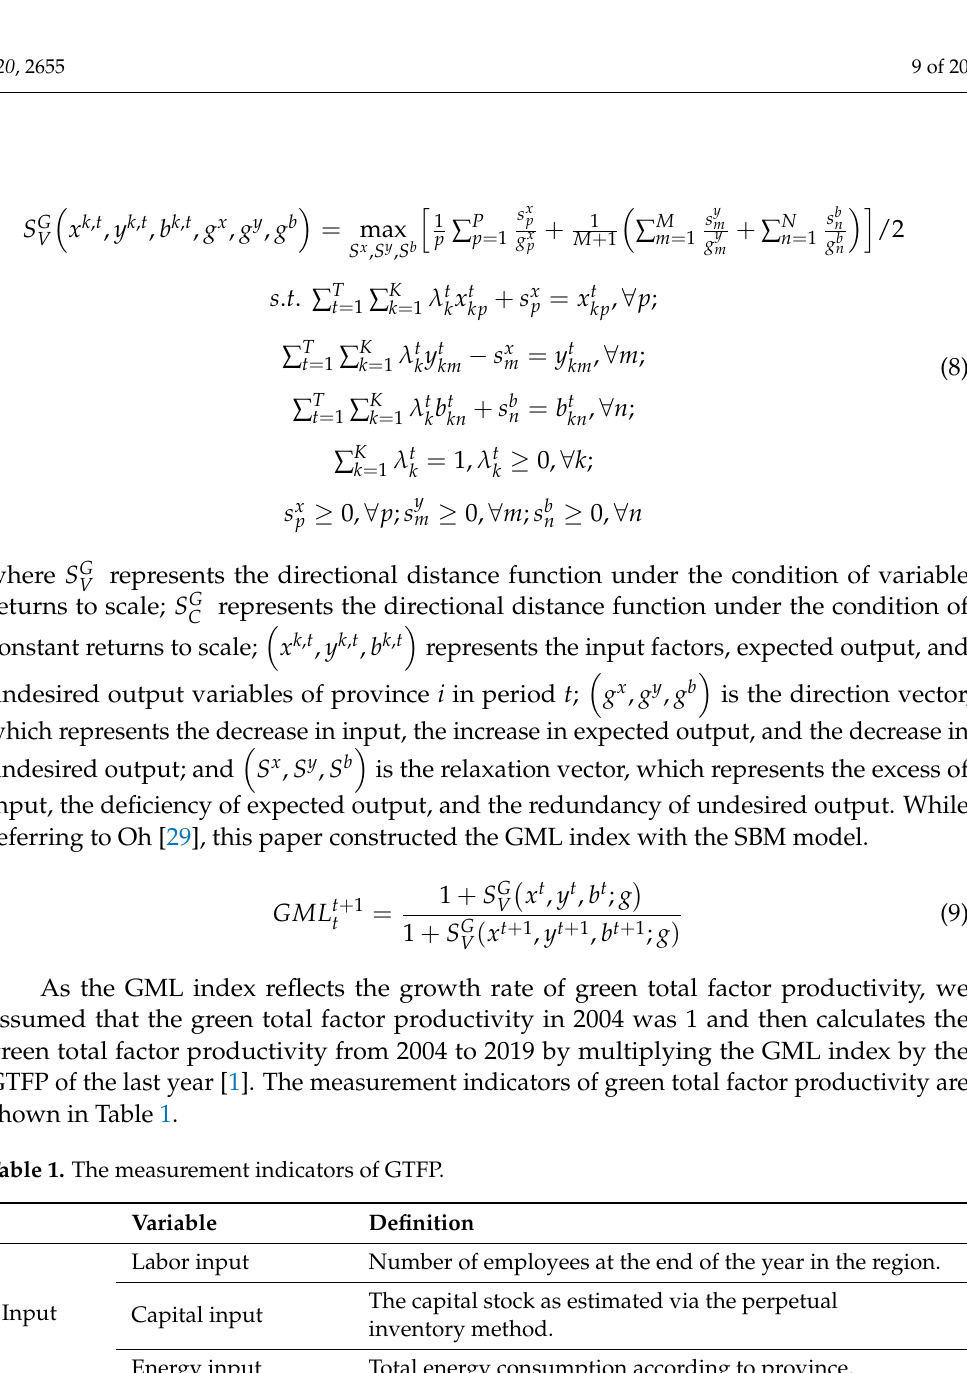
Table 1. The measurement indicators of GTFP. Variable Definition Labor input Number of employees at the end of the year in the region. The capital stock as estimated via the perpetual Input Capital input inventory method. Energy input Total energy consumption according to province. Desirable output GDP of each province. General industrial solid-waste production Output Industrial wastewater emissions Undesirable output Carbon dioxide emissions Industrial sulfur dioxide